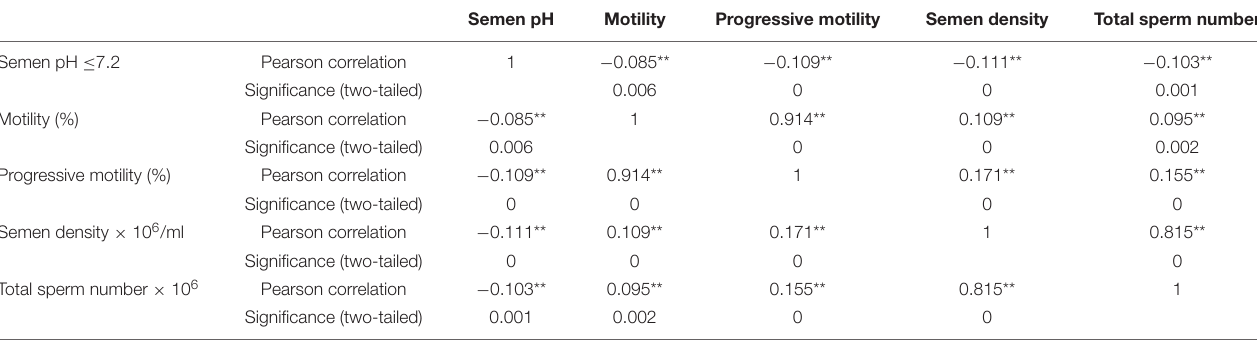
TABLE 1 | Correlation analysis of semen quality indicators.